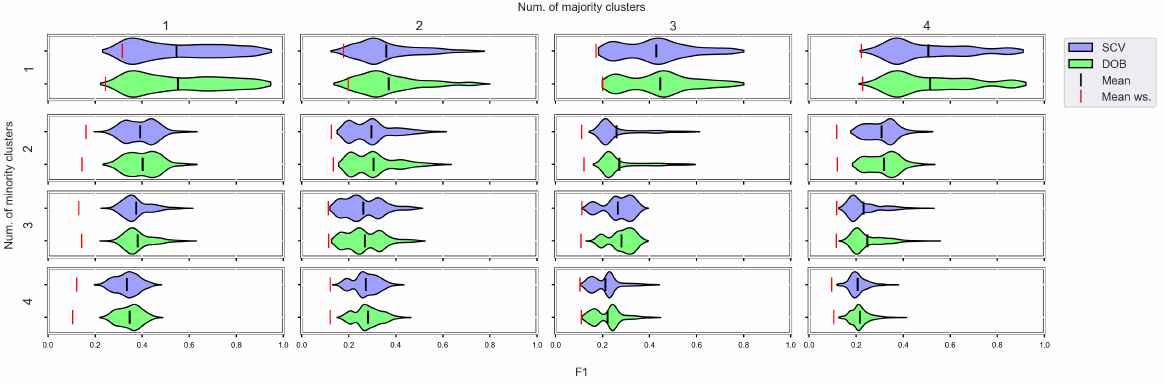
Figure A10. F 1 values concerning the number of clusters in the minority and majority classes in the case of the kNN classifier. (IR16).